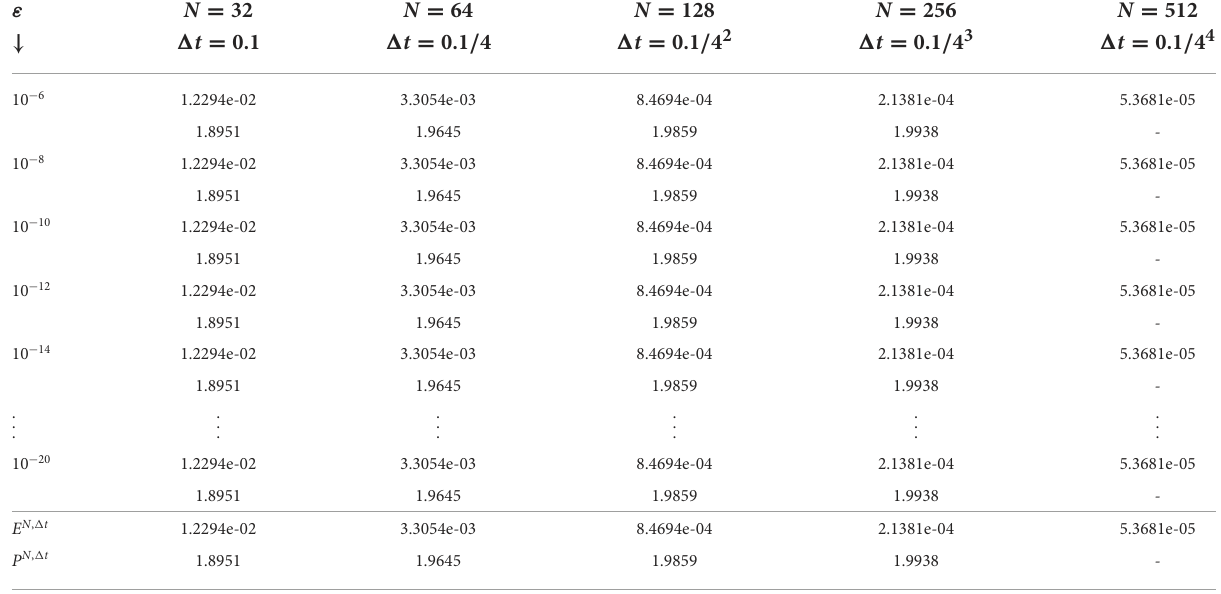
TABLE 1 Maximum absolute error and rate of convergence of the scheme for Example (1).